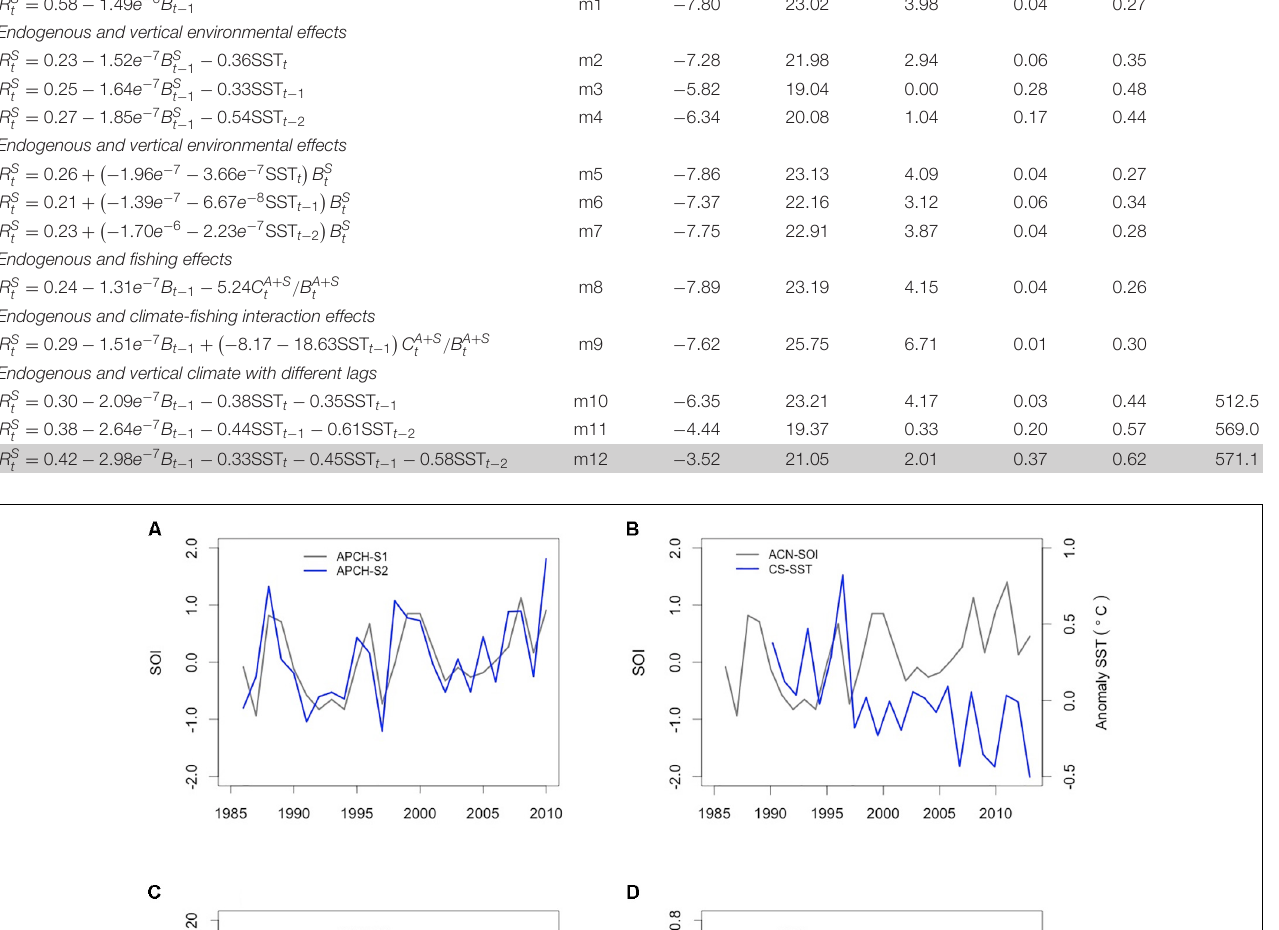
are fragmented for the anchovy and CS fisheries in Chile because they span a short time window, show discontinuity, and do not always have a consistent sampling window